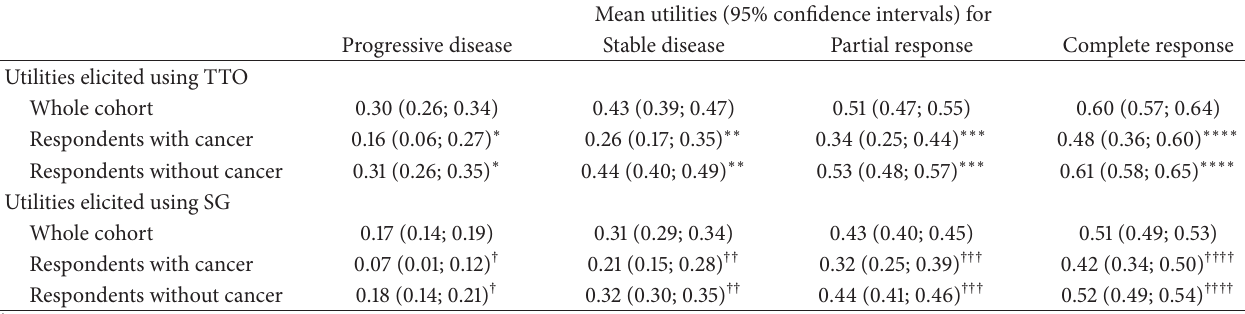
Table 3: Mean utilities (95% confidence intervals) for ASTS health states, stratified by respondents’ cancer status and elicitation method.